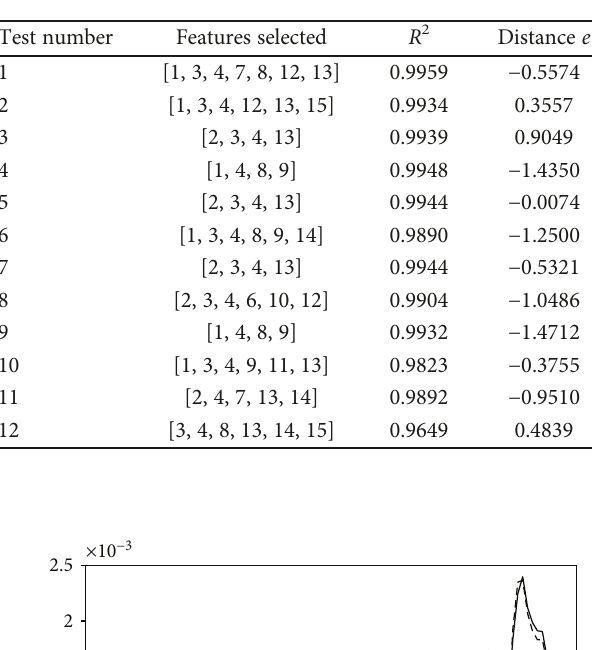
Table 5: Optimization selection results of dynamic response features.